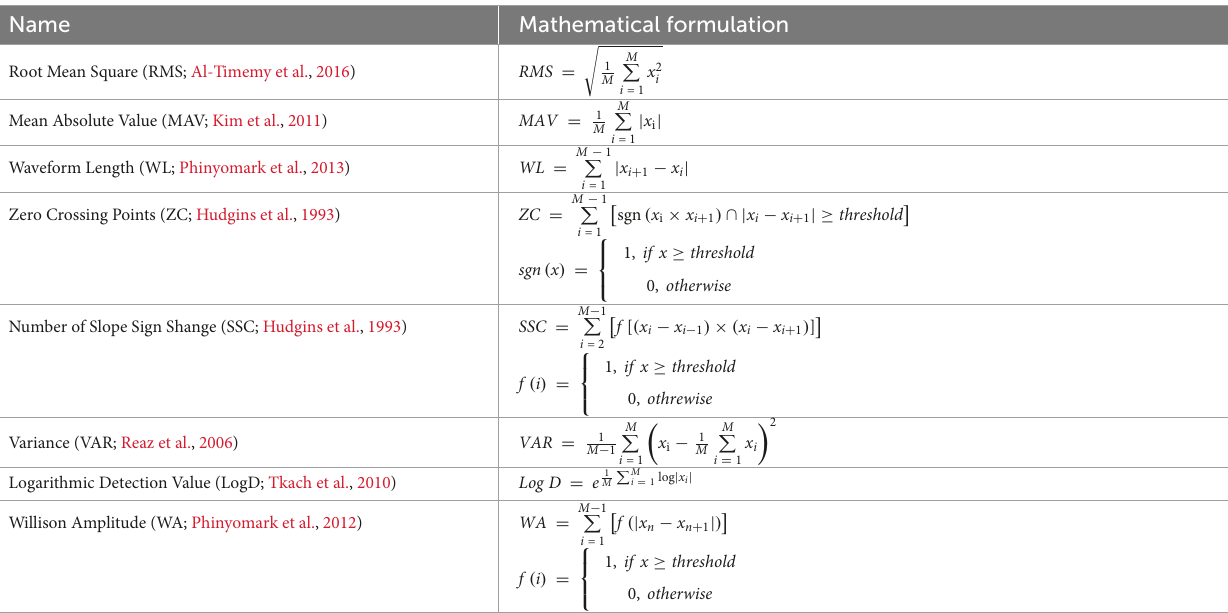
TABLE 1 Time-domain features with a mathematical